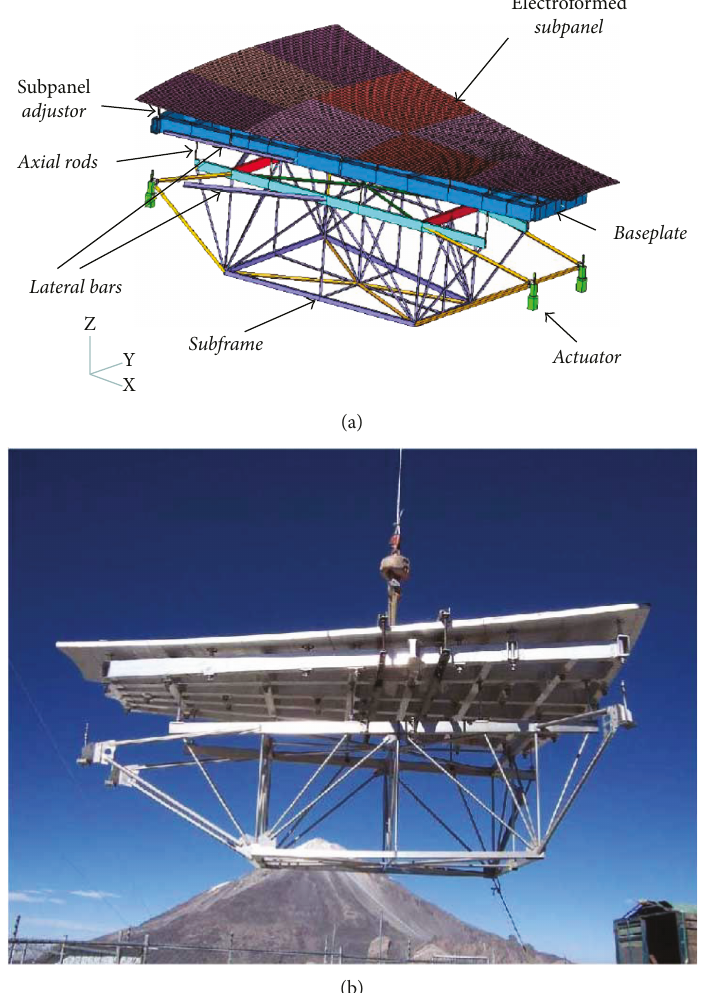
Figure 7: Support structure of LMT combination panels [66, 67]. (a) Schematic of LMT segment design; (b) photograph of support structure of an LMT combination